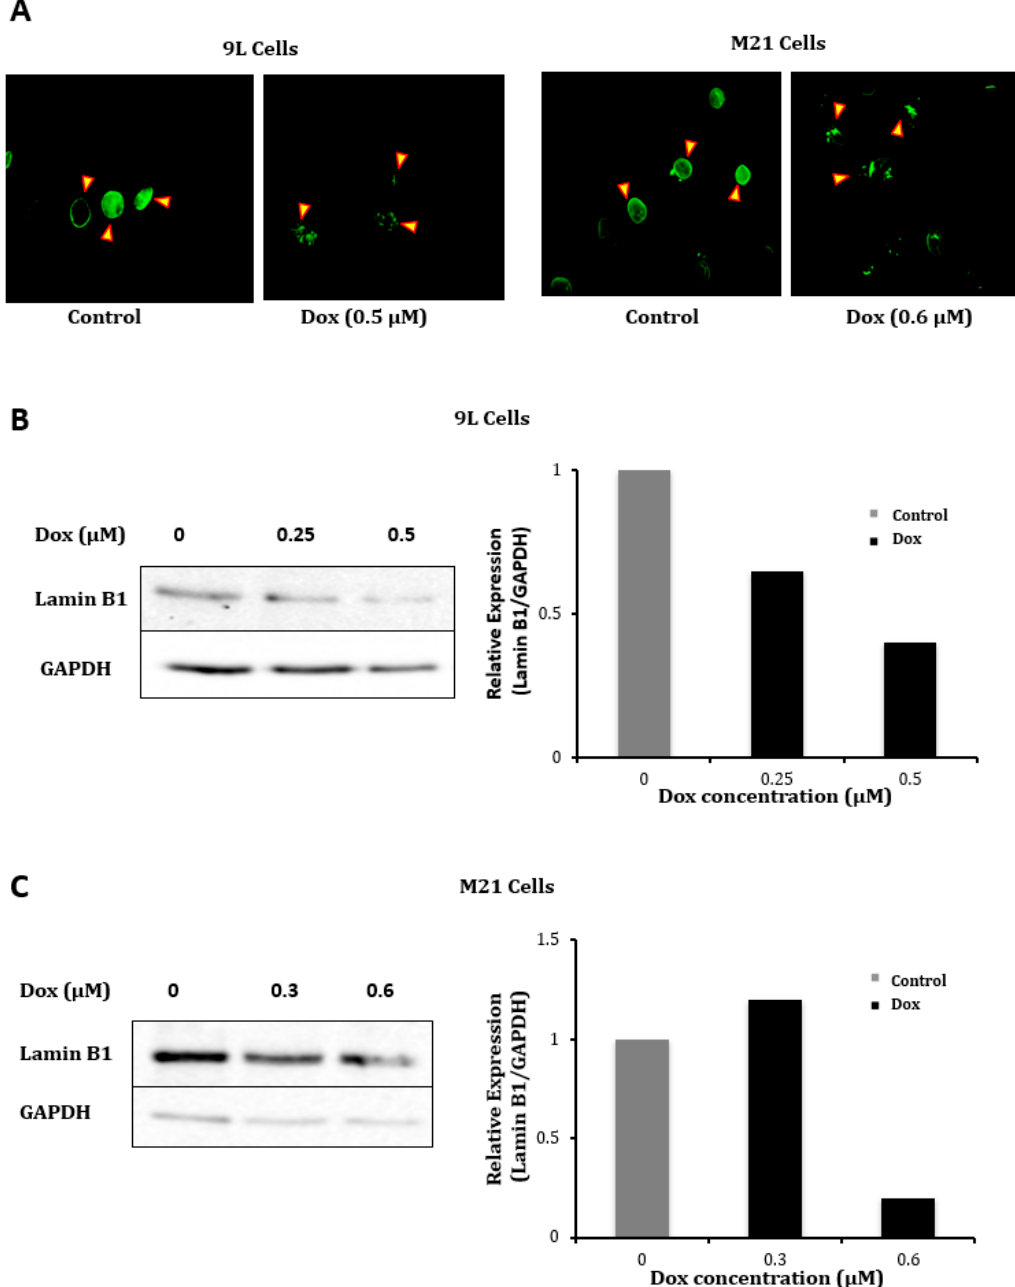
Figure 4. Dox reduces expression of the lamin B1 protein . ( A ) Immunofluorescence staining of the lamin B1 protein, which is a composition of the nuclear membrane, in 9L and M21 cells following Dox treatment. Pictures were taken by a fluorescent microscope. Lamin B1 staining shows that borders of the nuclear membranes (arrows) are thick in control untreated cells, while they are thinner in Dox-treated 9L and M21 cells. Original magnification ×400 . ( B , C ) Western blot analysis of lamin B1 expression in 9L and M21 cells, respectively, following treatment with increasing doses of Dox. Graphs show quantification of the bands in the Western blots and were obtained by normalizing the lamin B1 expression to GAPDH, then presented as fold change compared to control untreated cells.